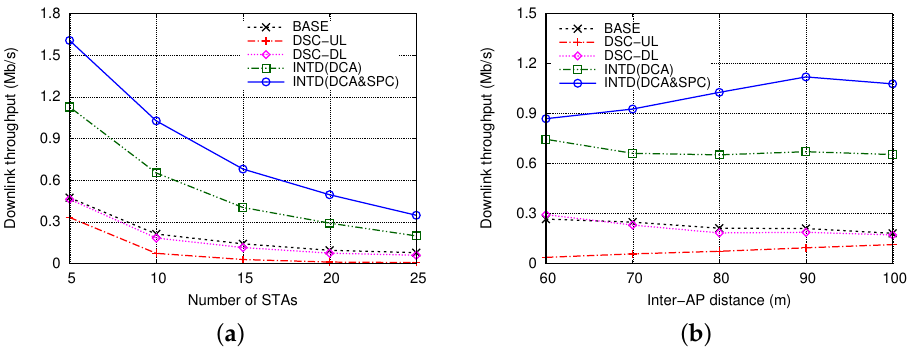
Figure 9. Downlink throughput with various values of ( a ) number of stations and ( b ) distance between access